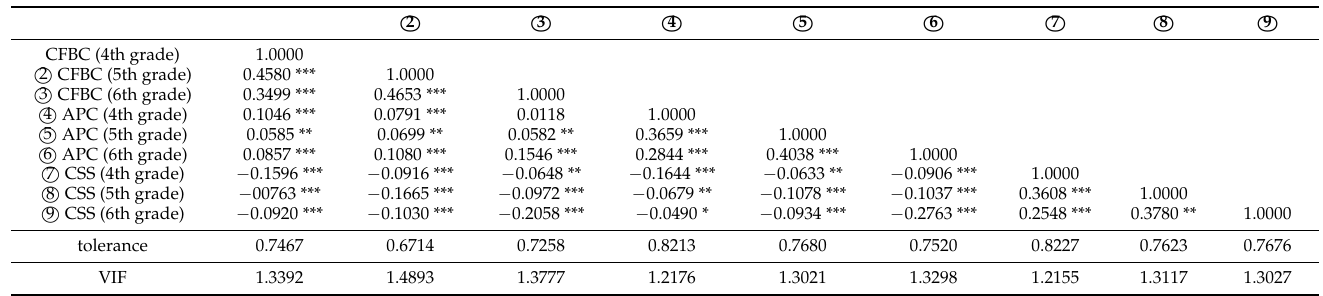
Table 3. Relationships between constants and multicollinearity